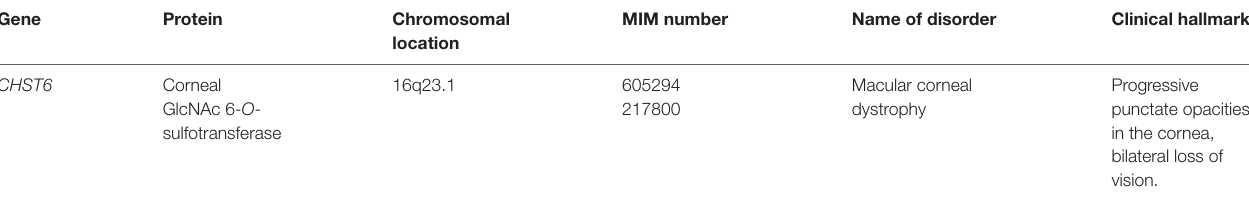
TABLE 4 | Congenital disorders of KS